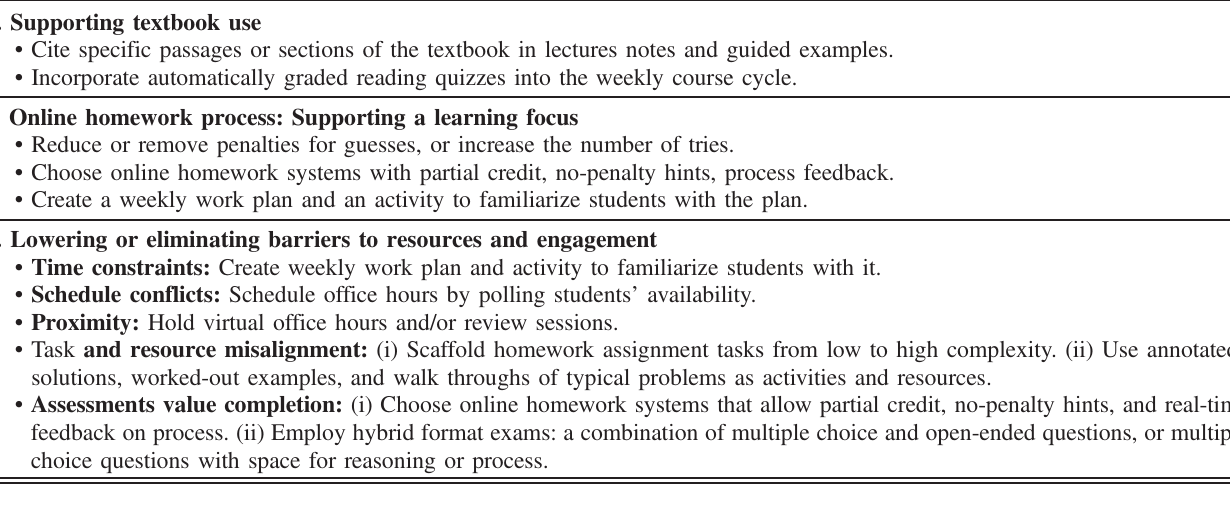
TABLE II. Teaching implications